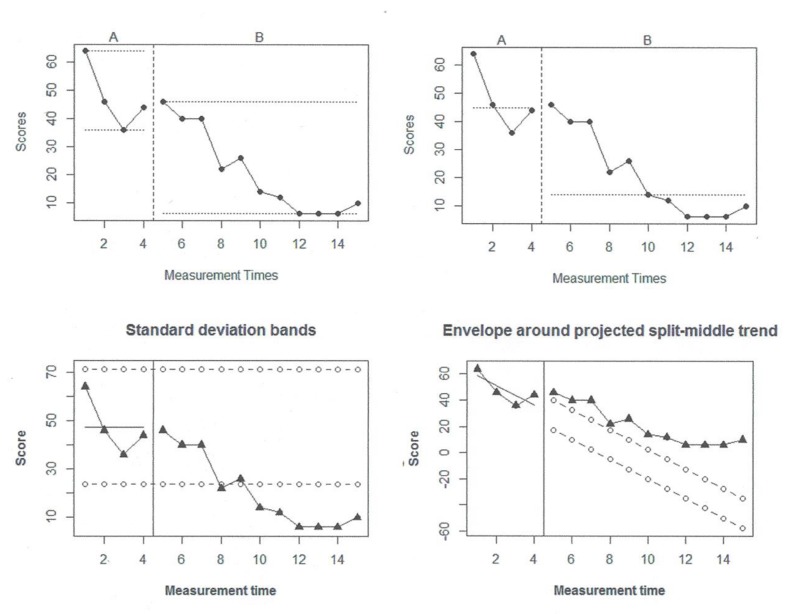
An illustration of visual sides using Taylor and Weems (2011) data on a participant called Elizabeth. Upper left panel-range bars. Upper right panel-medians. Lower left panel-2-standard deviation bands. Lower right panel-stability envelope around split middle trend.